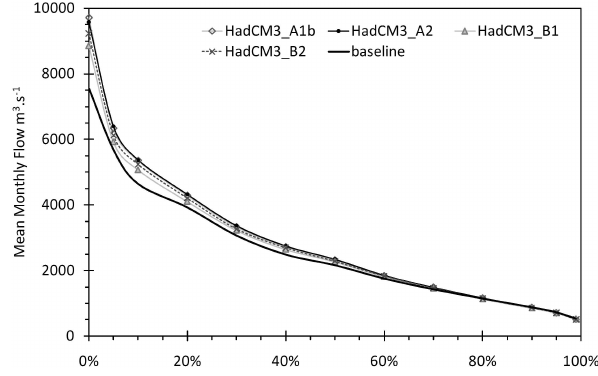
Fig. 4. Projected mean monthly flow duration curves under different SRES emission scenarios using HadCM3 in the Rio Grande basin along with the detrended 1961–1990 baseline or control